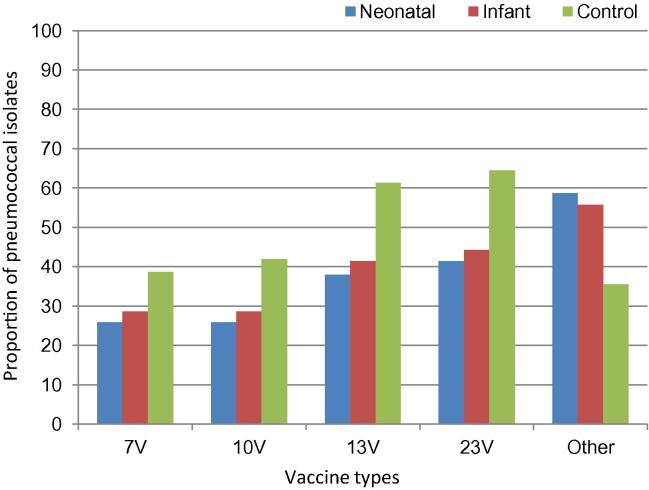
Proportion of pneumococcal serotypes in nasopharyngeal swabs covered by 7vPCV, 10vPCV, 13vPCV and 23PPV, and those not present in any licensed vaccine (‘Other’), according to vaccine cohort at 9 months of age.